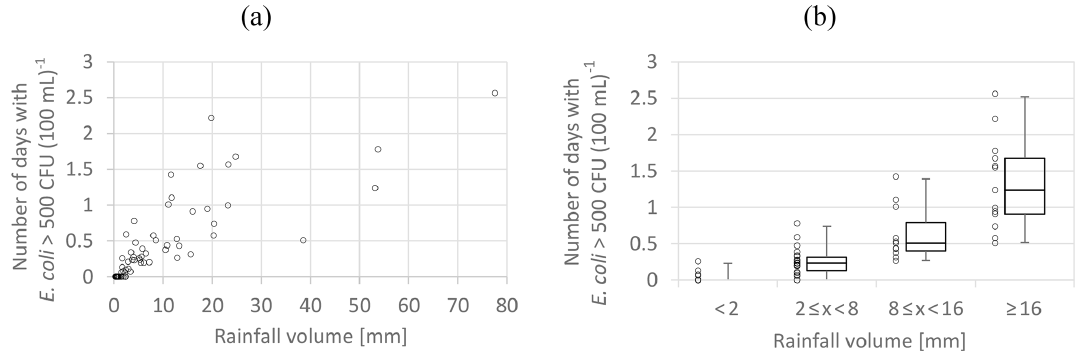
Figure 10. (a) Correlation between the simulated number of days with seawater E. coli concentrations above 500CFU(100mL) − 1 at Coco Beach and the rainfall volume. (b) The rainfall volume is categorized into four different ranges. The whisker boxes show 1st, 25th, 50th, 75th and 99th percentiles.